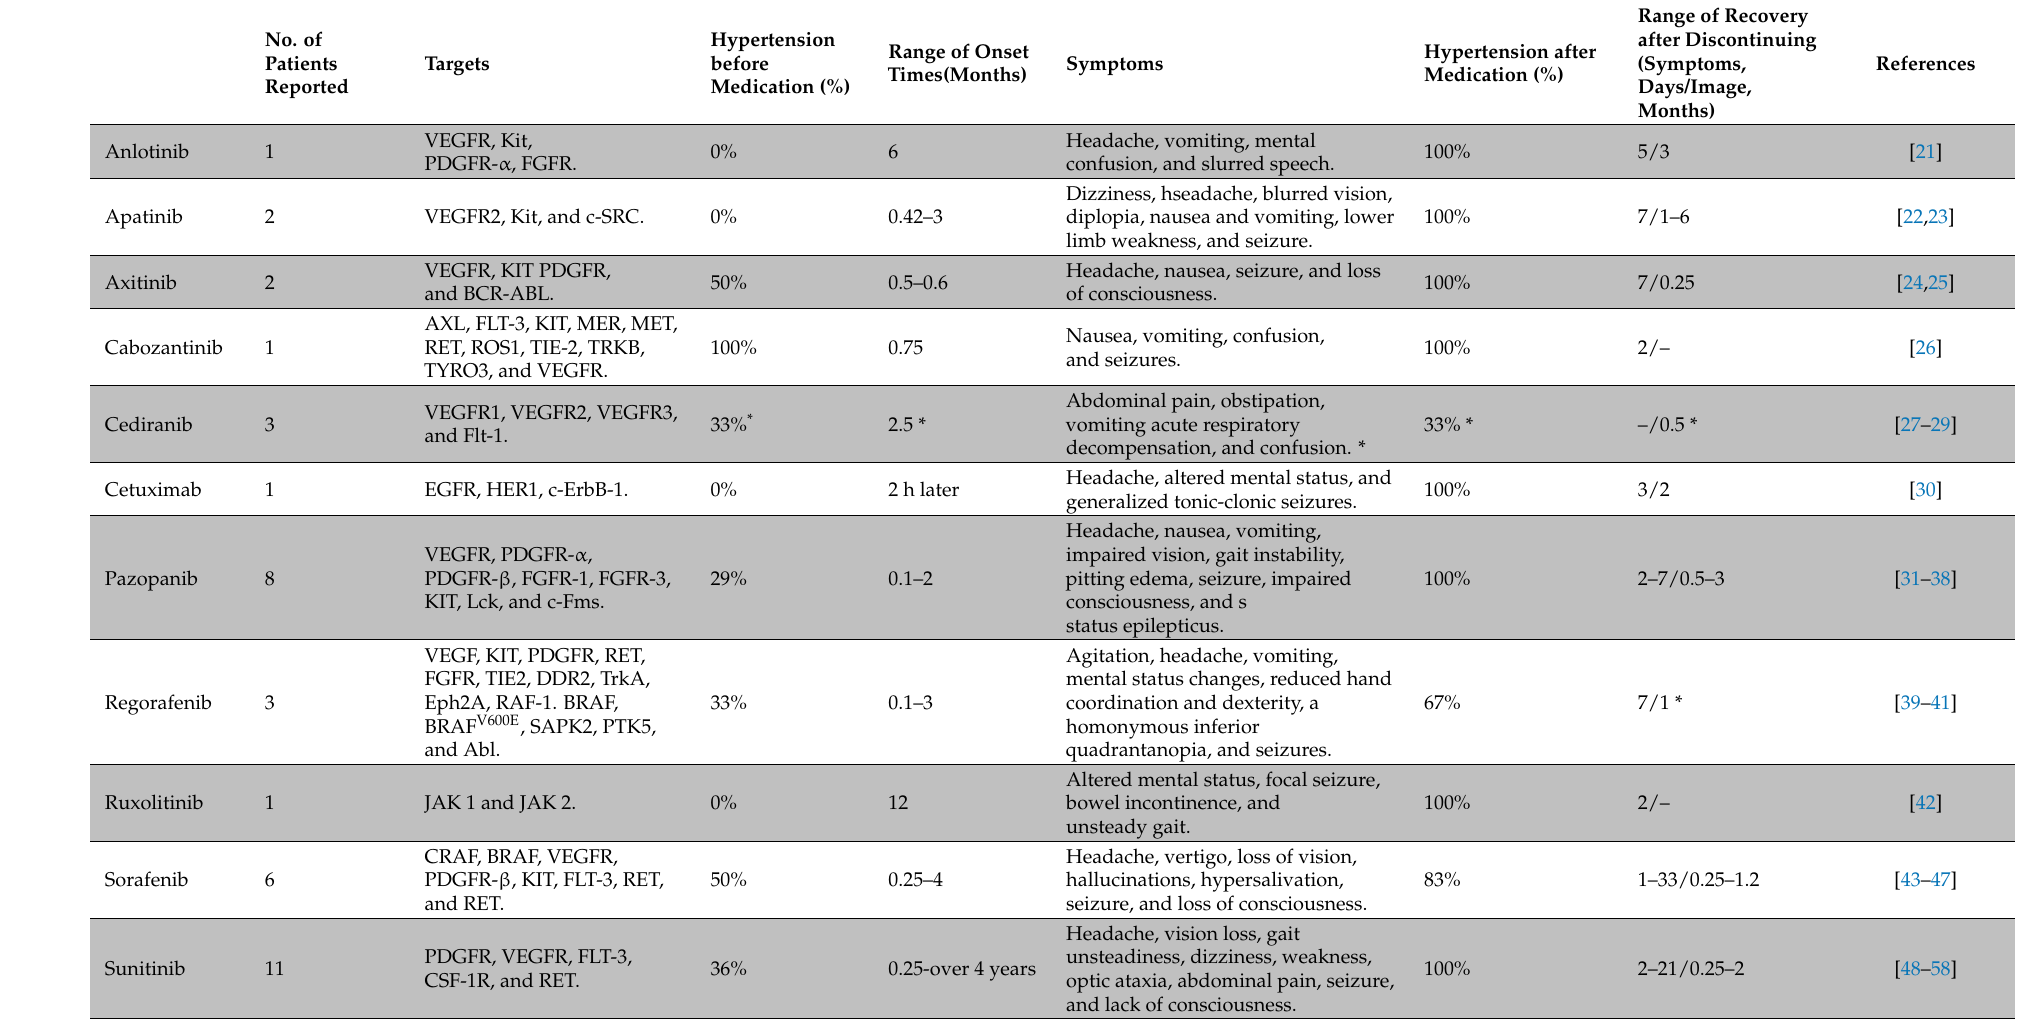
Table 1. Case reports of TKI-associated PRES from literature after